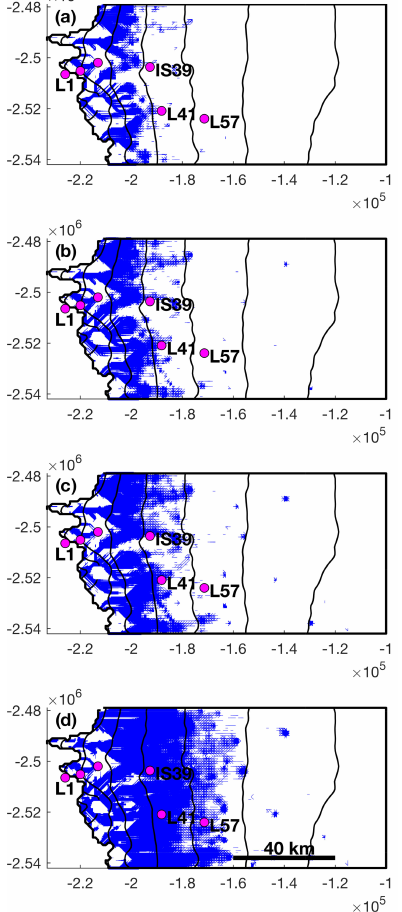
Figure 12. Channelized system at maximum extent: (a) 2009; (b) 2011; (c) 2012; (d) 2011 × 4. Moulin locations used as tracer injections sites in Chandler et al. (2013) are shown in purple. Two moulin locations are unlabelled for clarity. Black lines correspond to 200m surface topography contours at the same elevations as in Fig. 1.